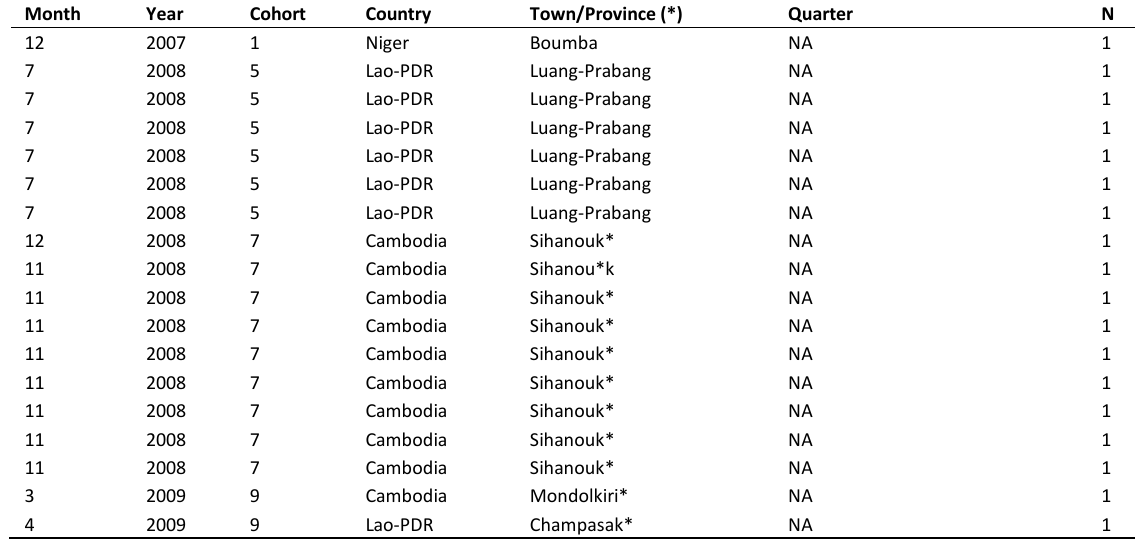
Table 1: Date of capture (Month, Year) of infected rodents, corresponding cohort with a 2-months generation time, location (Country, City or Province, Quarter) and number of Trypanosoma lewisi